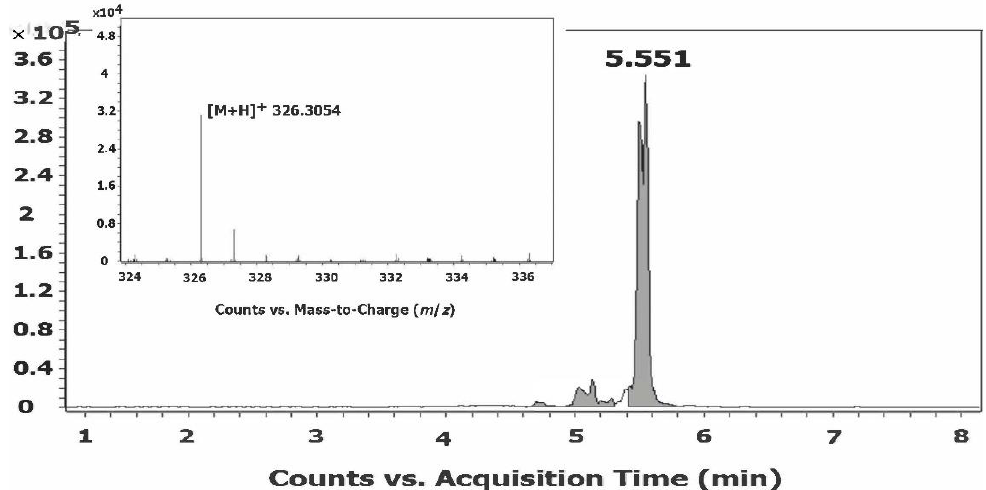
Figure 2. Identification of N -oleoylethanolamine in an extract prepared from T. castaneum by LC/QTOF-MS. The EIC peak and mass spectrum (inset) of endogenous N -oleoylethanolamine matched those of the N -oleoylethanolamine standard (Supplementary Materials Figure S9). These data are representative of the data collected for each long-chain fatty acid amide identified from T. castaneum .